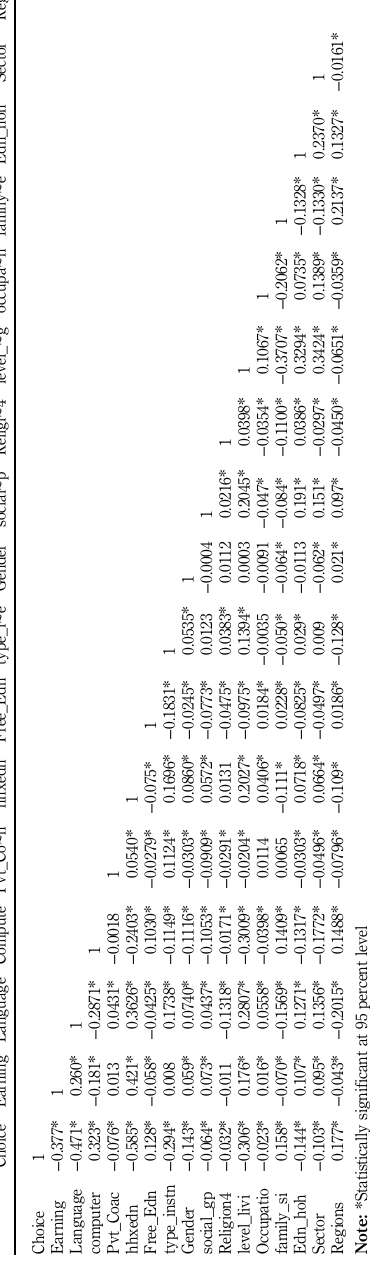
Table AI. Correlation matrix of dependent variable and selected